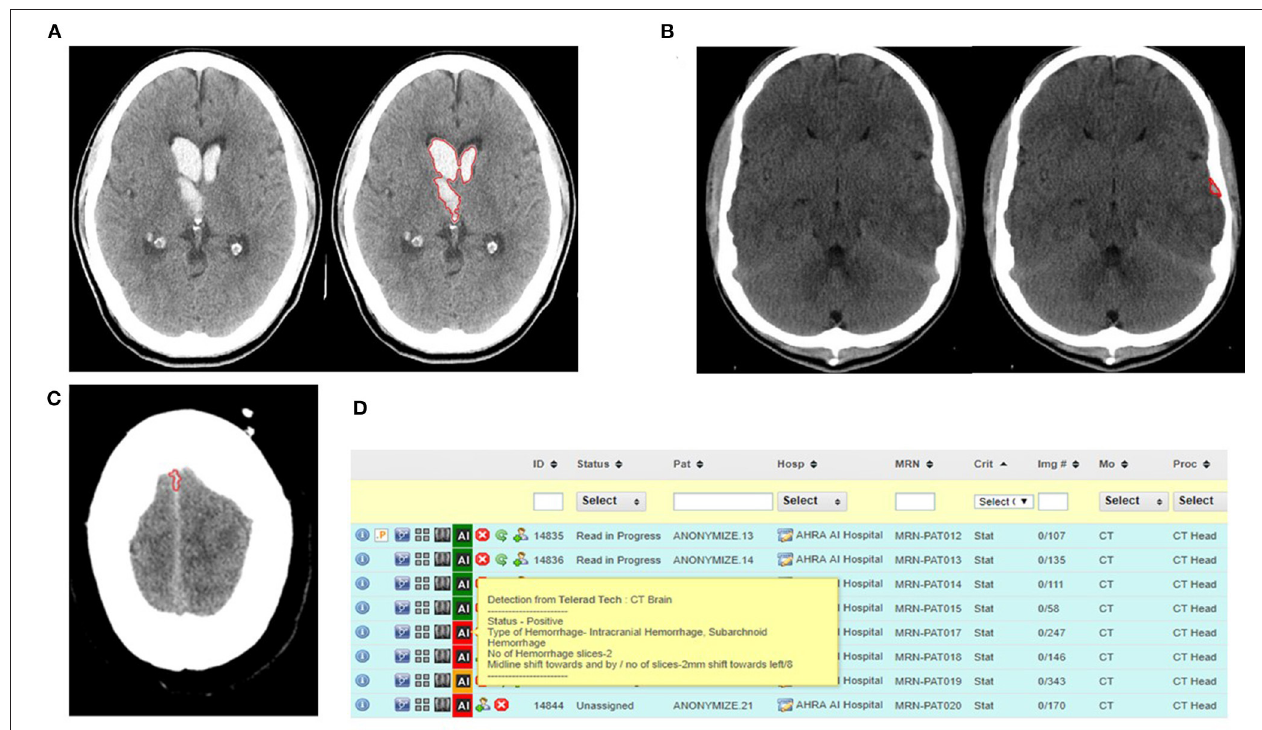
FIGURE 1 | (A) Automated detection and segmentation of hemorrhage in the right thalamus and bilateral ventricles. (B) Automated detection and segmentation of extra-axial hemorrhage in the left temporal convexity. (C) False positive for intracranial hemorrhage with false detection of a normal hyperdense falx as hemorrhage. (D) Illustration of the AI tool integrated into the worklist for triage of cases with the cases positive for hemorrhage coded as red to draw radiologist’s attention